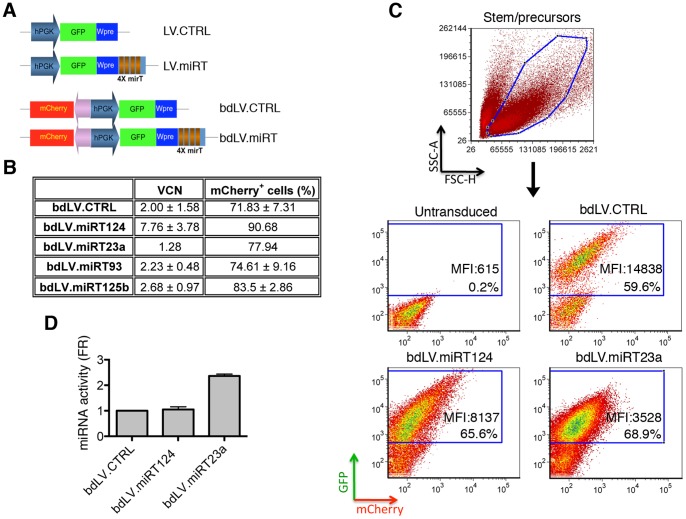
miR-124 and miR-23a activity in NSCs monitored using LV.mirT.(A) Cartoon showing monocystronic (LVs) and bidirectional (bdLV) miRNA-regulated (LV.miRT, bdLV.miRT) and control vectors (LV.CTRL, bdLV.CTRL). (B) Efficacy of transduction in NSCs measured as VCN (assessed by taqman qPCR) and as percentage of mCherry+ cells (assessed by indirect immunofluorescence). Data are mean ± SEM, n = 1–3 independent experiments. (C) Representative dot plots of untransduced, bdLV.CTRL- and bdLV.miRT-transduced stem/precursors (bdLV.miRT23a and bdLV.miRT124) gated on physical parameters. GFP/mCherry expression is shown, the percentages in the plots indicate transduction levels. MFI, mean fluorescence intensity of GFP signal. (D) miRNA activity is expressed as fold repression (FR) of GFP expression measured in bdLV.miRT124- and bdLV.miRT23a-transduced cells as compared to bdLV.CTRL-transduced cells. FR was calculated as previously described [26]: FR = TGRmiRT/TGRCTRL; TGR (transgene ratio) = MFIGFP/MFImCherry. Data are the mean ± SEM; n = 3 independent experiments.